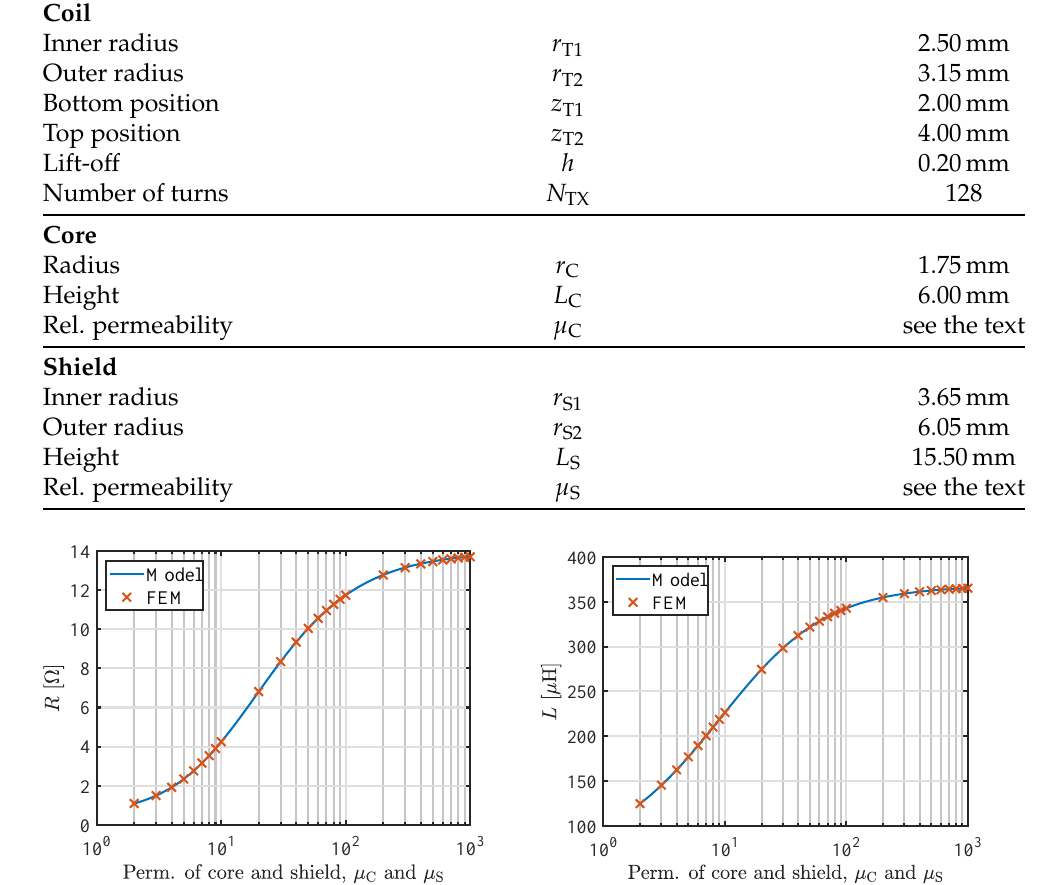
Figure 3. Comparison of the model predictions and results of the FEM study for resistance R ( left ) and inductance L ( right ) of the sensor depending on the permeability of the core µ C and shield µ S assuming that µ C = µ S . The plate has σ = 5MS/m and µ r = 50, and the frequency is